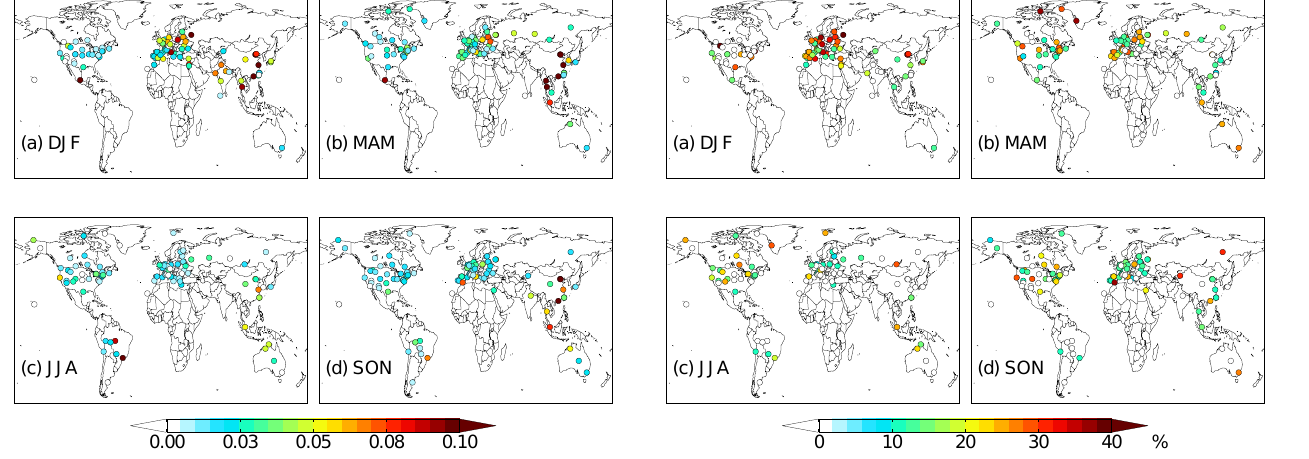
Figure 4. Derived seasonal mean BrC-AAOD contributions to to- tal AAOD at 440nm from AERONET observations (2005–2014, 10-year average) in northern hemispheric (a) winter, (b) spring, (c) summer, and (d) fall. The color bar is saturated at 40% to cap- ture regional variation, but values up to 45% are estimated at spe- cific